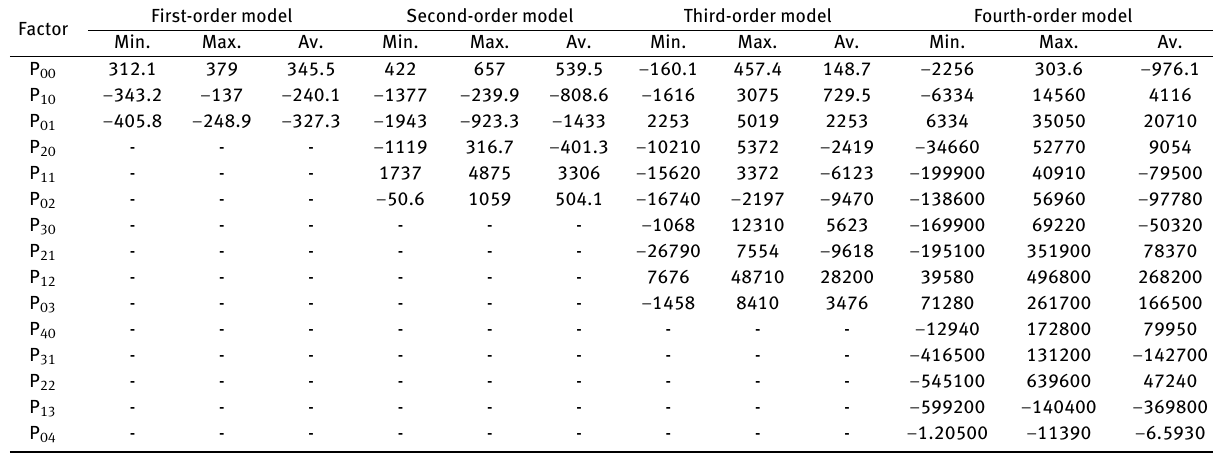
Table 4: Parameters defing four polynomials suggested for caluculations of the allowable bearing capacity driven pile of 6 m length